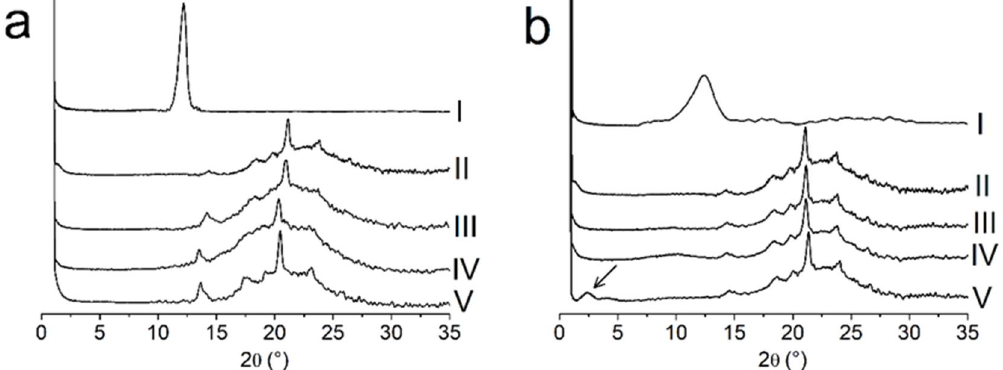
Figure 3. X-ray diffractograms in the 0.9 ◦ to 35.0 ◦ (2 θ ) range for ( a ) GO (trace I), TPS (trace II) and TPS with GO incorporated at 0.5 mass% (trace III), 1.0 mass% (trace IV) and 2.0 mass% (trace V) contents; ( b ) rGO-g (trace I), TPS (trace II) and TPS with rGO-g incorporated at 0.5 mass% (trace III), 1.0 mass% (trace IV) and 2.0 mass% (trace V) contents.